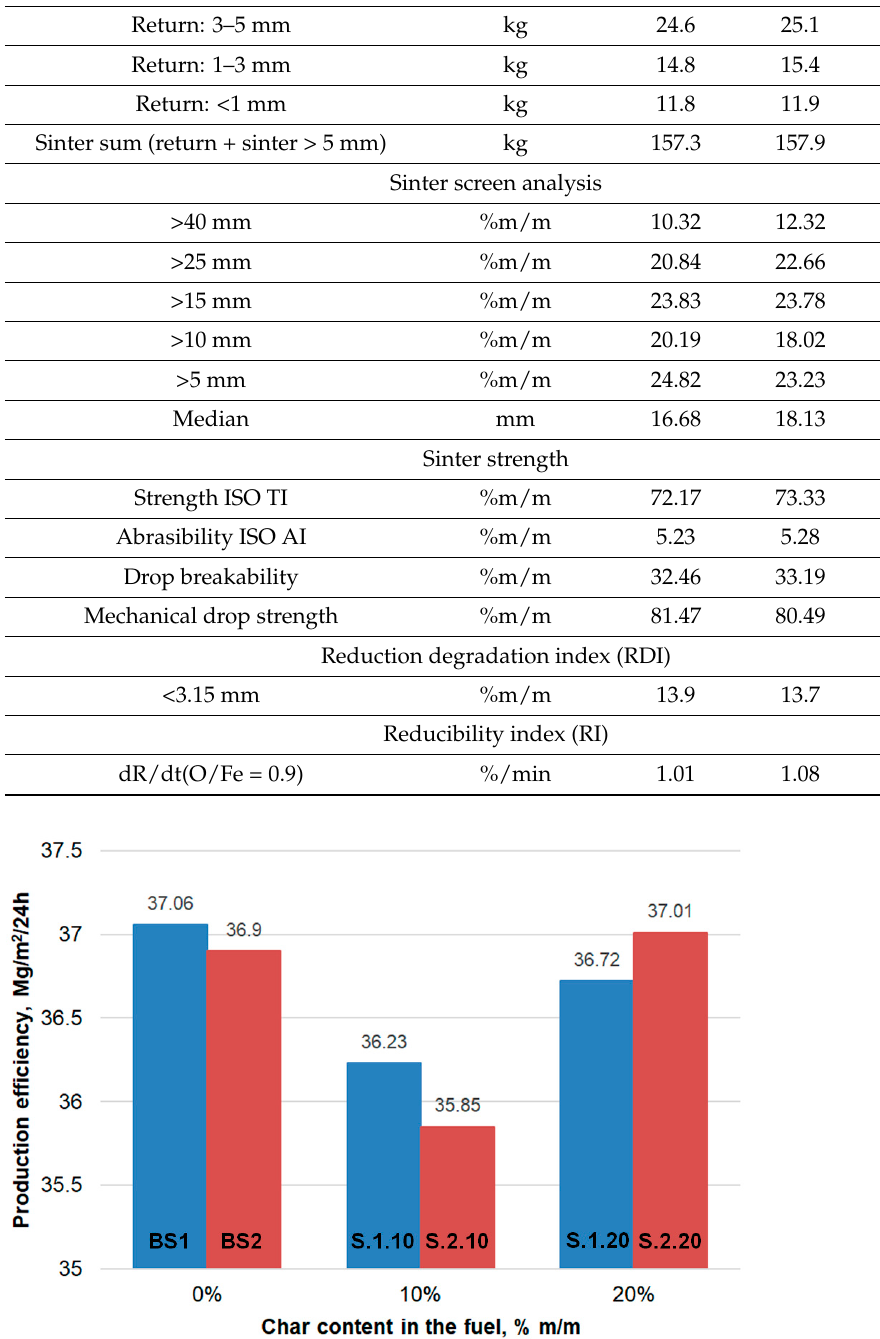
Figure 3. Changes in production efficiency depending on the content of char from waste tires in the fuel.